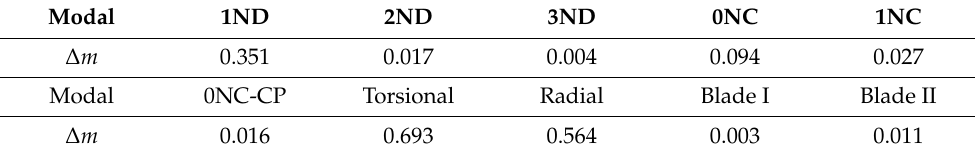
Figure 6. Influence of the constraint condition on the natural frequencies. If only the maximum difference of natural frequencies under different constraints is concerned, it can be described by ∆ m = ( f max − f min ) f S . f max and f min are the maximum and minimum natural frequencies of a mode under different constraints. The ∆ m of each mode is shown in Table 3. It can be seen that the Torsional mode, the Radial mode, the 1ND mode, and the 0NC mode varied most significantly with the constraint condition. The maximum differences in the natural frequencies of these four modes under different constraints were 69.3%, 56.4%, 35.1%, and 9.4%, respectively. When these modes are involved in practical engineering problems, it is necessary to carefully analyze whether the setting of constraint condition is reasonable, especially considering the influence of the shaft or even the rotor system. For example, if the constraint condition is not accurate, it is likely to misjudge the resonance characteristics of the runner when the 1ND exciting force appears in the unit. Table 3. Maximum differences of natural frequencies under different